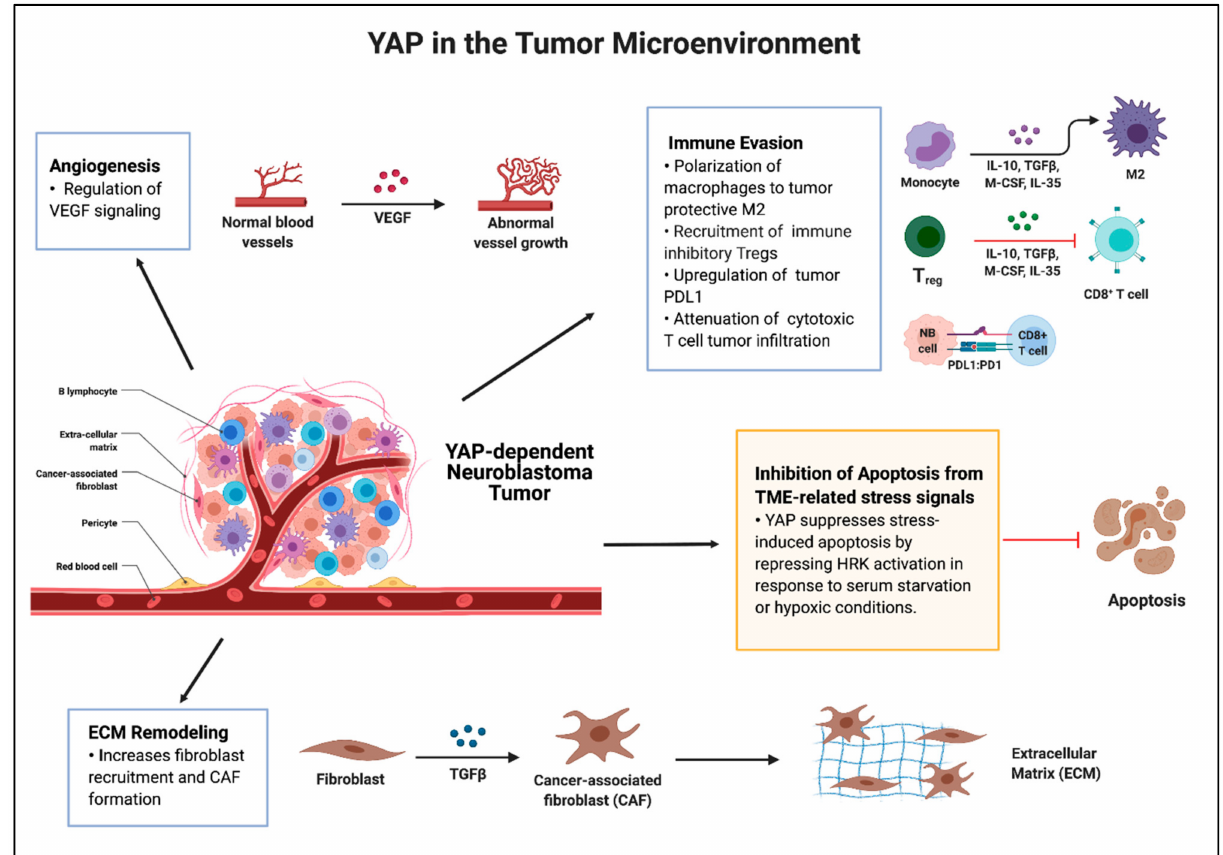
Figure 2. Potential roles for YAP in the neuroblastoma TME and areas for further investigation. YAP plays a role in every aspect of the TME from angiogenesis, ECM remodeling, immune evasion, and regulation of TME-related target genes, such as HRK . We have published on the novel relationship between YAP and HRK in neuroblastoma leading to regulation of stress-induced apoptosis in the tumor environment (yellow highlighted box). Areas of YAP TME regulation in other cancers that have also been described as TME factors in neuroblastoma support that further investigation should be pursued (blue boxes). Adapted from “The Tumor Microenvironment: Overview of Cancer-Associated Changes”, by BioRender.com (2021). Retrieved from https://app.biorender.com/biorender-templates (accessed on 8 September